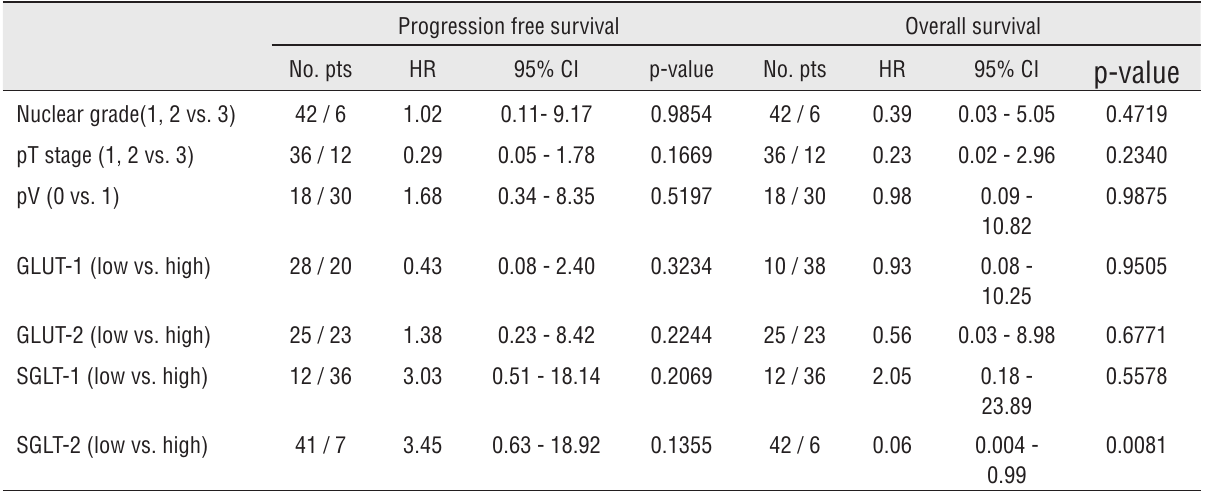
Table 3 - Univariate analysis for various potential prognostic factors in progression free and overall survival in non- metastatic